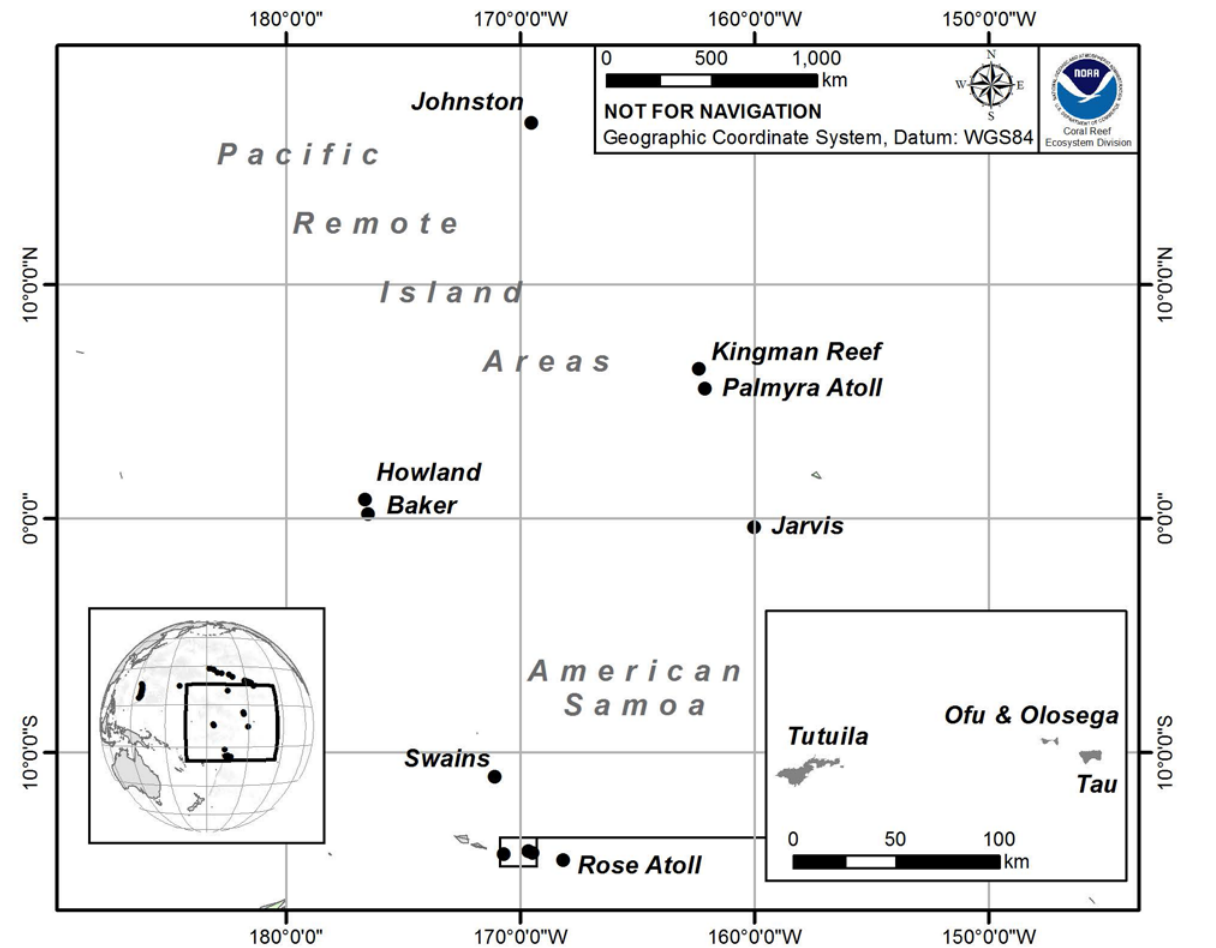
Fig 1. Geographical location of the U.S.-Affiliated Pacific Islands and Atolls where Calcification Accretion Units (CAUs) were deployed and recovered between 2010 and